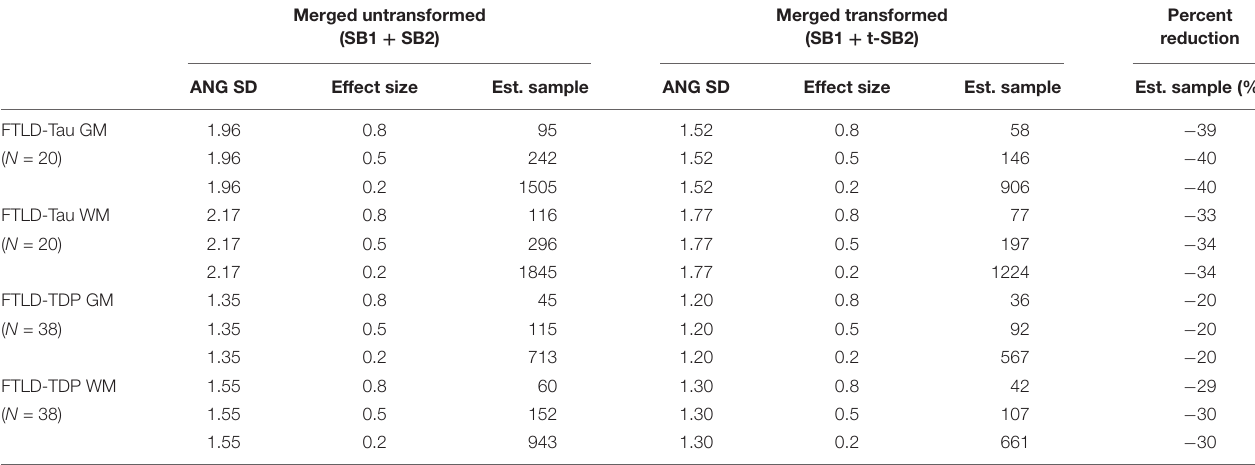
TABLE 5 | Outcomes of power analysis using merged SB1 and SB2/t-SB2 data to measure improvement before vs. after the transformation (Step 3). Merged untransformed Merged transformed Percent (SB1 + SB2) (SB1 + t-SB2) reduction ANG SD Effect size Est. sample ANG SD Effect size Est. sample Est. sample